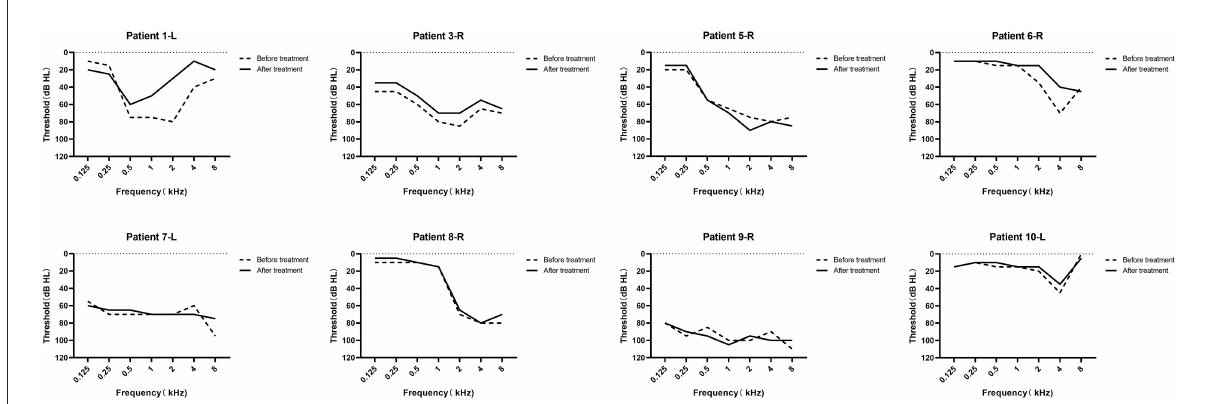
FIGURE3 Audiograms of the eight patients who recorded completed pure tone audiometry (PTA) results before and after drug treatment. The “L” and “R” means the tumor side. The dashed line represents the hearing threshold before treatment, and the solid line represents the hearing threshold after treatment.